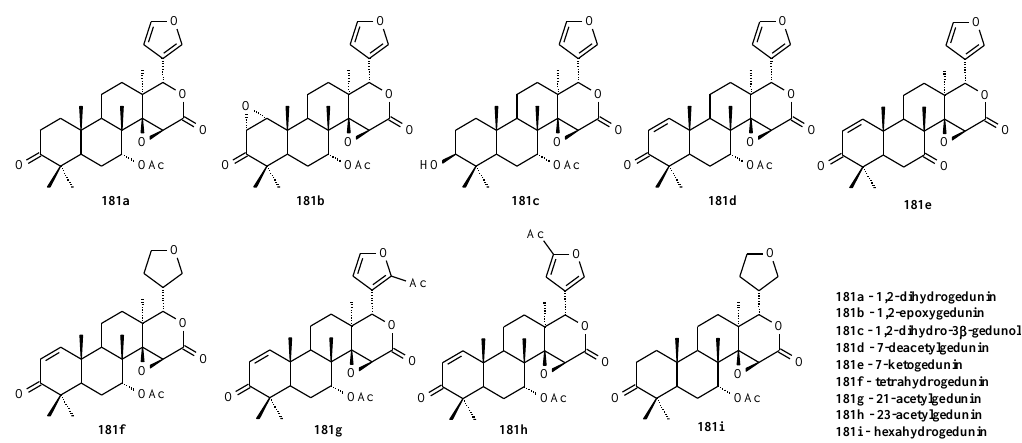
Figure 2. Gedunin ( 181 ) semi-synthetic derivatives [70].